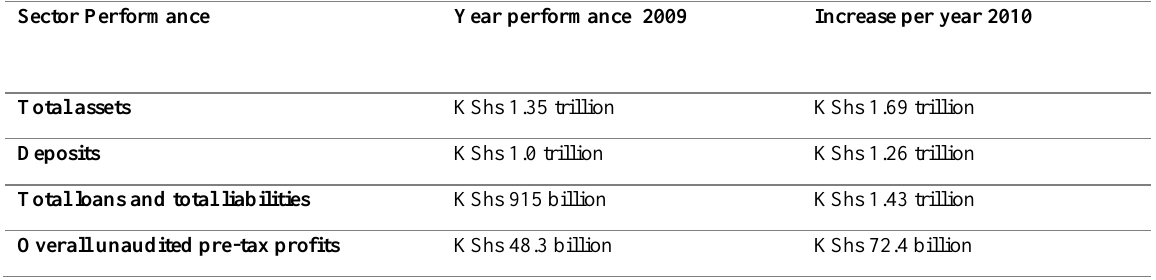
Table 2: The growth recorded after the survey was as follows: